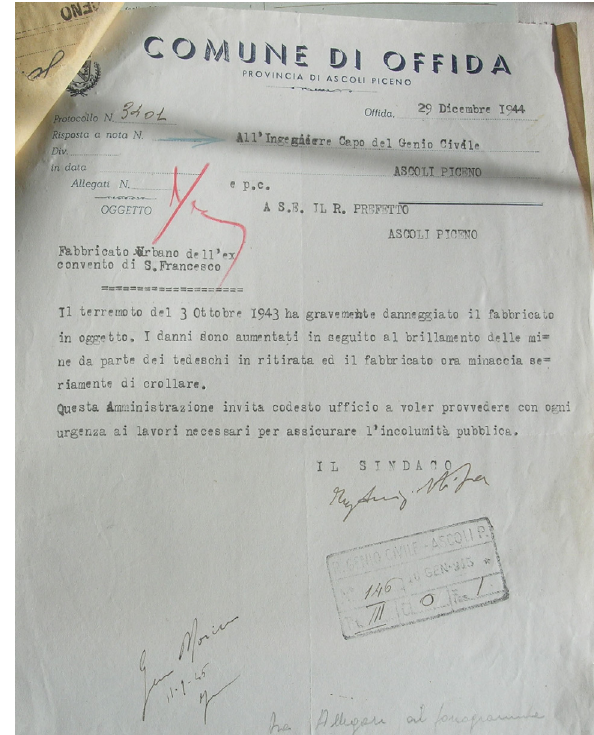
Figure 4. The Mayor of Offida describes the damage incurred by the San Francesco monastery to the Head Engineer of the Genio Civile of Ascoli Piceno, [ASCOf 1943-1944]. Translation: “The Oc- tober 3, 1943 earthquake seriously damaged the aforesaid building. The damage increased after the setting off of the mines laid by the German army during its retreat”